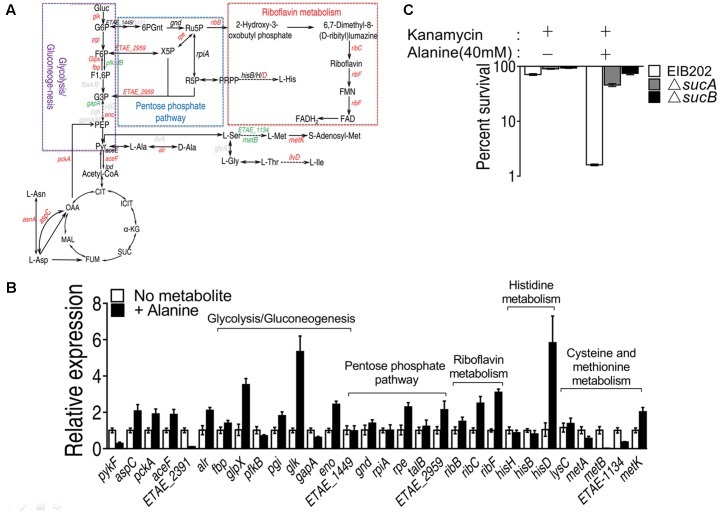
Alanine metabolism connected to riboflavin metabolism through TCA cycle, glucogenesis pathway and pentose phosphate pathway. (A) Metabolic network in association with exogenous alanine; (B) Transcriptional level of genes of alanine, aspartate and glutamate metabolism, TCA cycle, glycolysis/glucogenesis pathway, pentose phosphate pathway, histine metabolism and cysteine methionine metabolism; (C) Percent survival of EIB202, ΔsucA or ΔsucB in the presence of kanamycin or alanine plus kanamycin. ∗p < 0.05, ∗∗p < 0.01, and ∗∗∗p < 0.001 as determined by Student’s t-test.